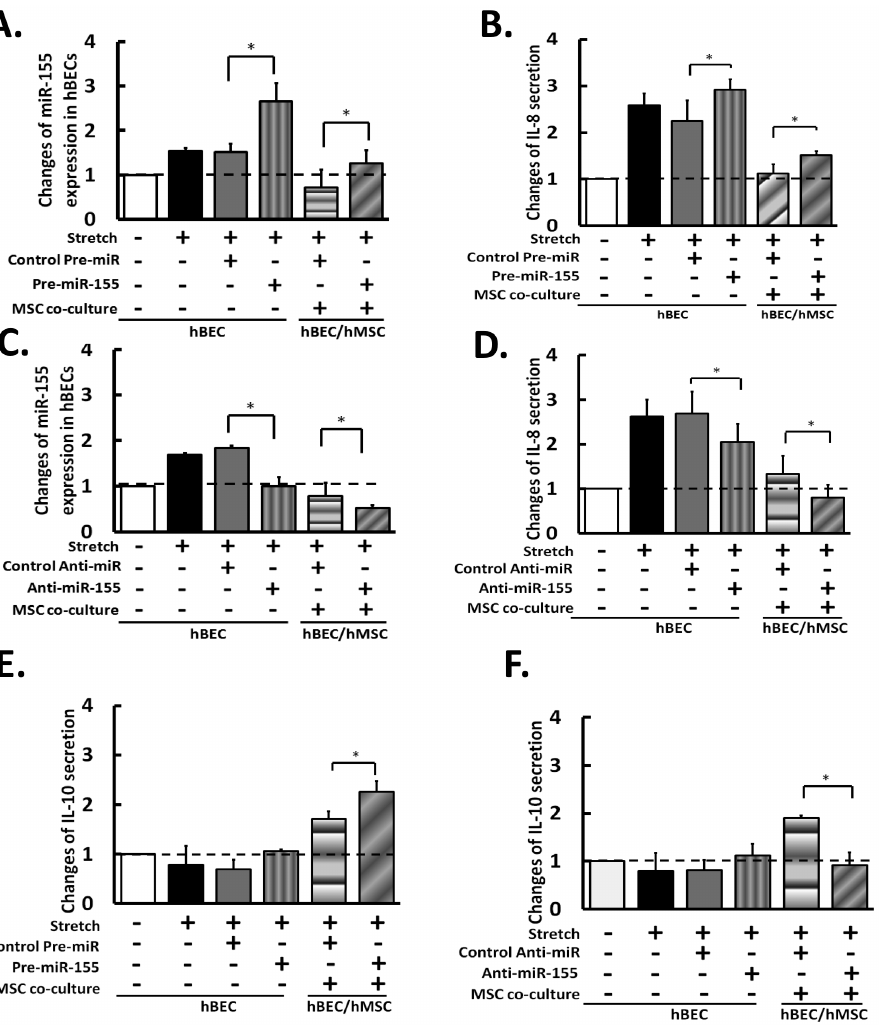
Figure 5. The role of miR-155 in hyperstretch-regulation of hBEC-hMSC inflammatory responses. The effects of overexpression of miR- 155 on (A) miR-155 levels and (B) IL-8 secretion in hBECs/hMSC co-culture under hyperstrech. The effects of anti-miR-155 on (C) miR-155 levels and (D) IL-8 secretion in hBECs/hMSC co-culture under hyperstrech. The effects of (E) overexpression of miR-155 and (F) anti-miR-155 on IL-10 secretion. In (D)–(F), the measurement of IL-8/10 secretion levels were done either in mono-culture (first four bars) and co-culture (5 th and 6 th bar) after treatments with pre-miR and anti-miR. The changes in cytokines secretion and mRNA expression are relative to static control. Data represent mean 6 s.e.m. *, P , 0.05; n=5. doi:10.1371/journal.pone.0071342.g005 hBEC IL-10 receptor (IL-10R) (Fig. 3F) abrogated the suppressive effect of hMSCs on IL-8 secretion by the co-cultured hBECs. These results indicate that hMSCs suppress hyperstretch-induced inflammation in hBECs via an increased secretion of IL-10, which inhibits IL-8 secretion by hBECs via a paracrine mechanism.